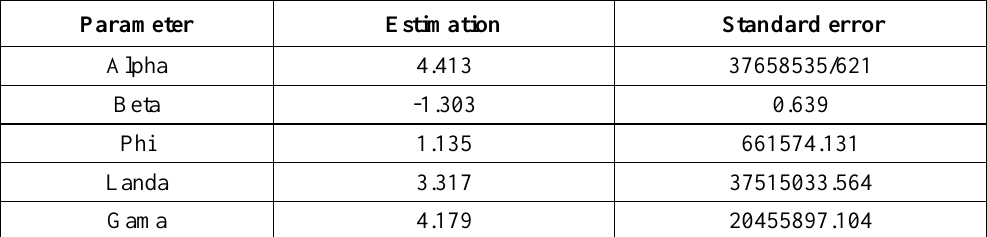
Table 7. Parameter estimation of 2017 sophisticated accrual parametric model by non-linear regression Parameter Estimation Standard error 4.413